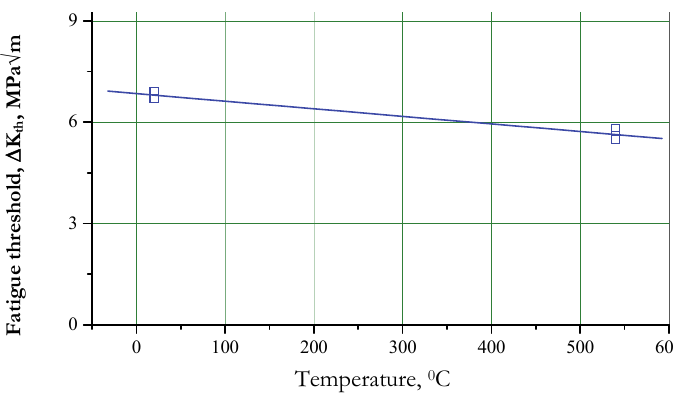
Figure 4: Fatigue threshold Δ K th vs. temperature in WM.